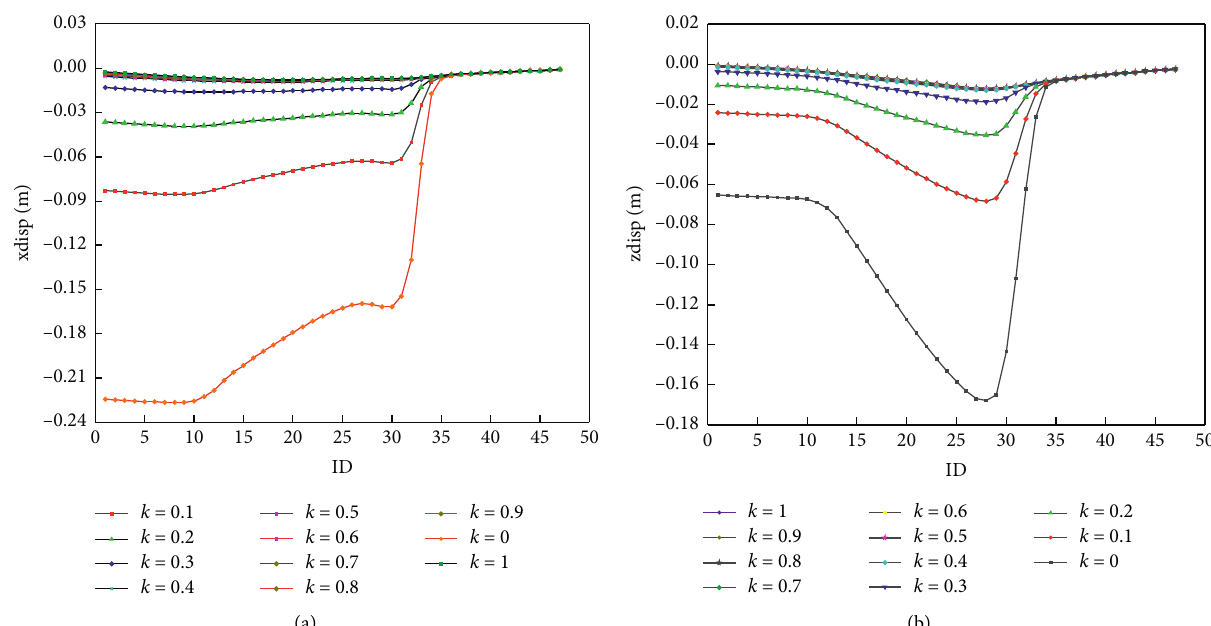
Figure 11: Displacement of the slope. (a) Horizontal displacement. (b) Vertical displacement.